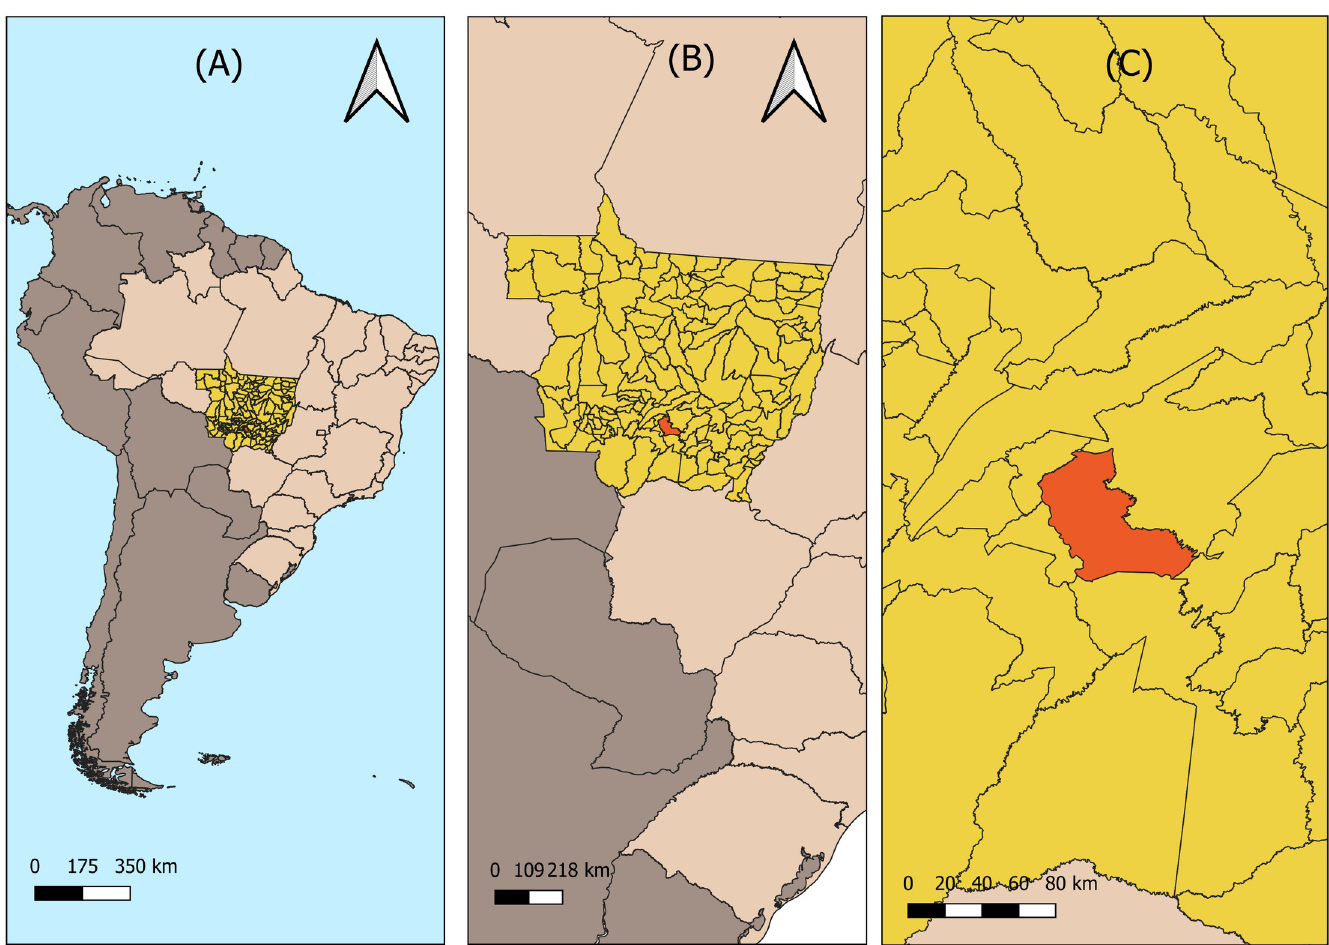
Fig 1. Location of Cuiaba´—Mato Grosso. (A) Brazil; (B) State of Mato Grosso; (C) City of Cuiaba´. Source: Instituto Brasileiro de Geografia e Estatı´stica (IBGE)–All maps are in public domain.